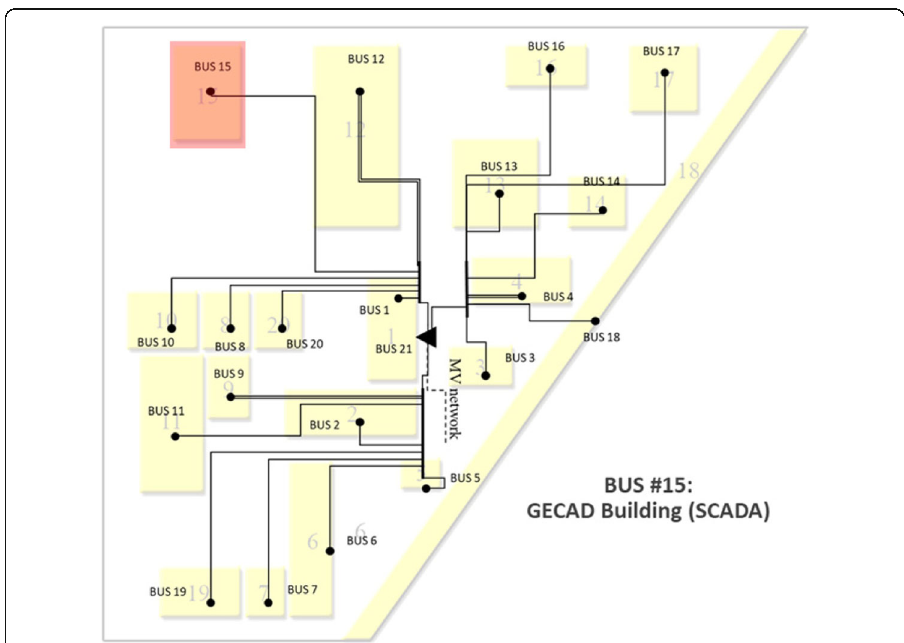
Fig. 5 Low voltage distribution network of university campus considered as an aggregation